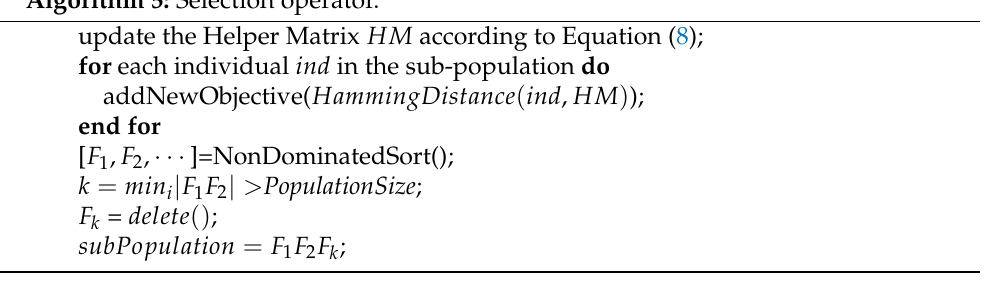
Algorithm 6: Adaptive population